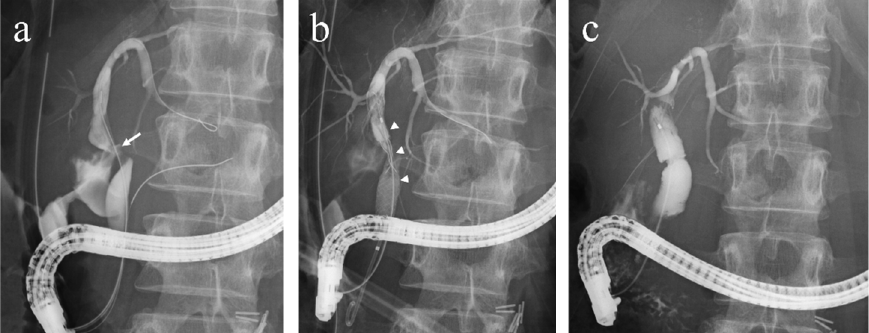
Figure 1. ( a ). After selective biliary cannulation, the bile leak was located by endoscopic retrograde cholangiography (ERC) (a white arrow). ( b ). A guidewire was placed over the leak, and the FCSEMS was deployed above the papilla under fluoroscopic guidance to seal the leak. The stent successfully bridged and sealed the leak (white arrowheads). ( c ). ERC following removal of the FCSEMS showed complete resolution of the bile